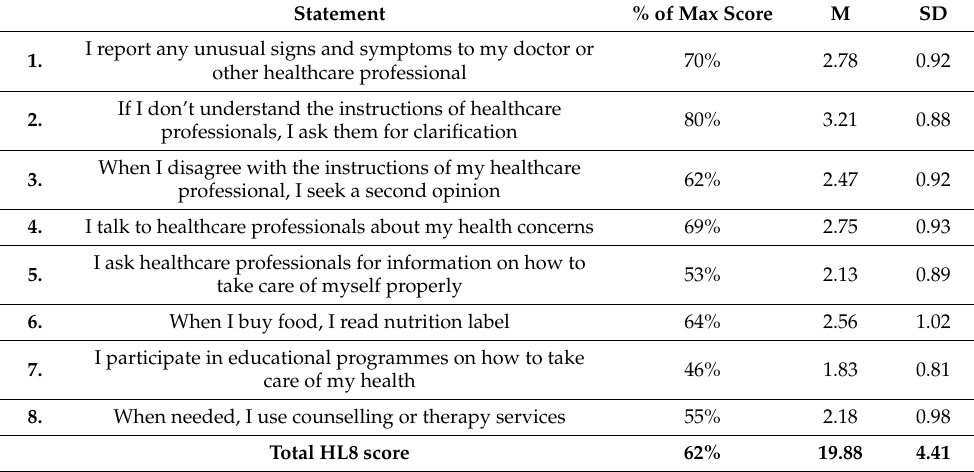
Table 6. Health literacy questionnaire